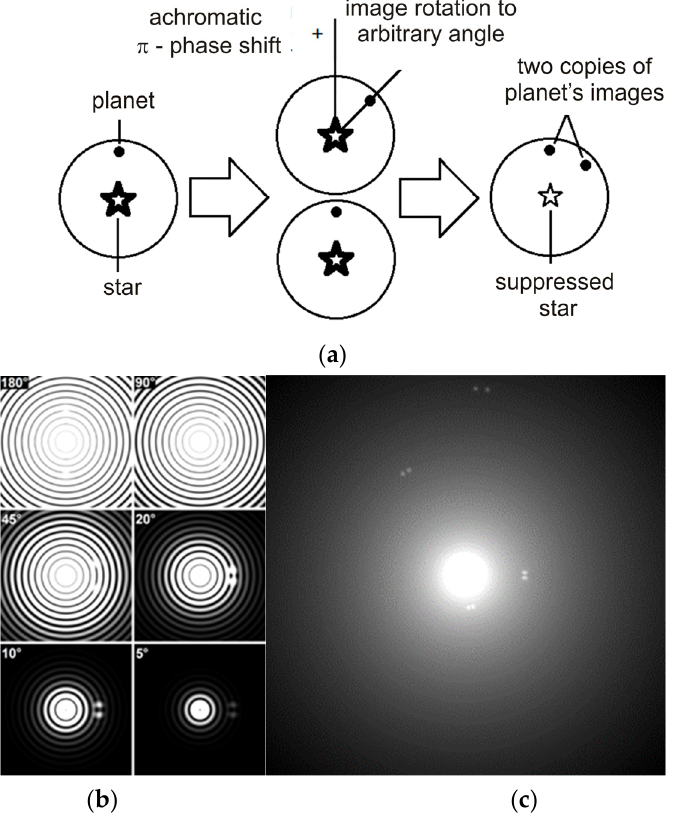
Figure 1. Rotation ‐ shear interfero ‐ coronagraph: principles and simulated output. ( a )—anti ‐ phase superposition on ‐ axis for stellar PSF (asterisk denoted) and doubling off ‐ axis planet’s PSF (dot denoted). ( b )—monochromatic starlight incomplete suppression, leakage considering the stellar size of Θ = 0.01 λ / D (@ D = 2.4 m, λ = 500 nm) by various rotational shears (the angles of rotation are noted), the shown planet PSF considered at the stellocentric separation of ρ 0 = 5 λ /D, and contrast ε = 10 − 8 . ( c )—in polychromatic band ( λ = 350–850 nm), picture of Solar System as observed from 10 pc with the telescope D = 2.4 m and the interfero ‐ coronagraph having 3.6° angular shear; Jupiter, Sat ‐